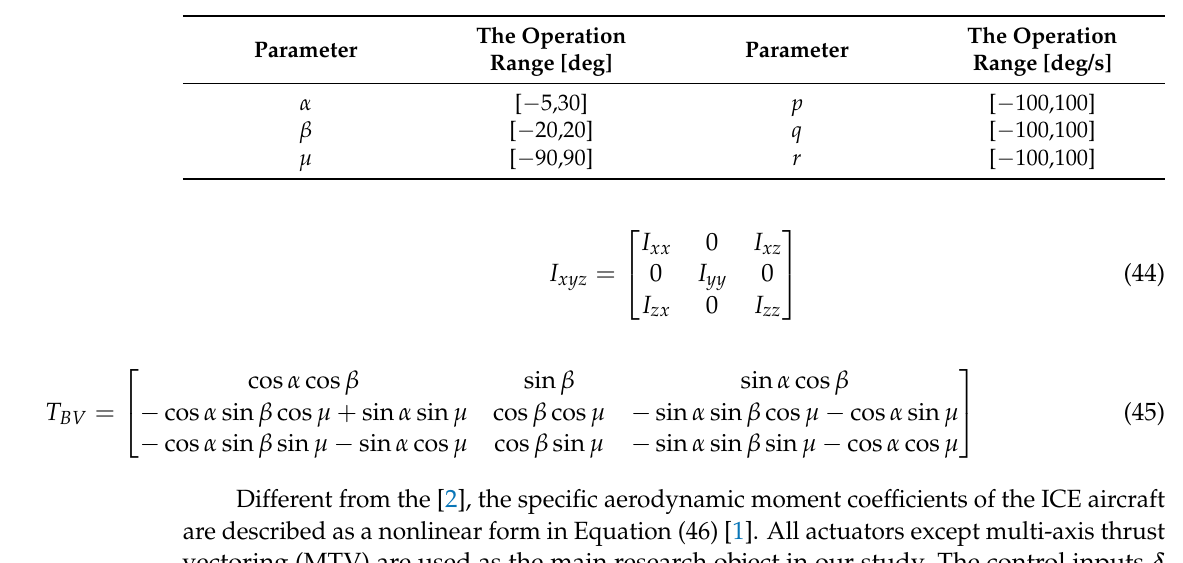
Table 2. The operation ranges of the angular rates and attitude